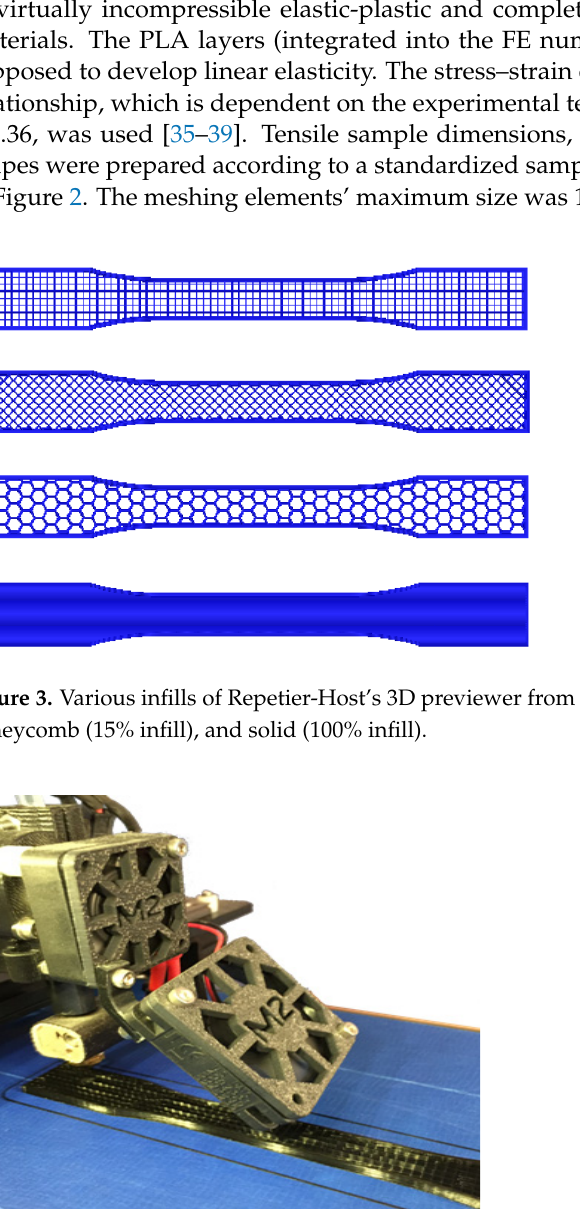
Figure 4. Picture of the printing process for rectangular shape infilled for the tensile test specimen. (Extruder nozzle temperature is equal to 215 °C and layer thickness is 0.3 mm.)